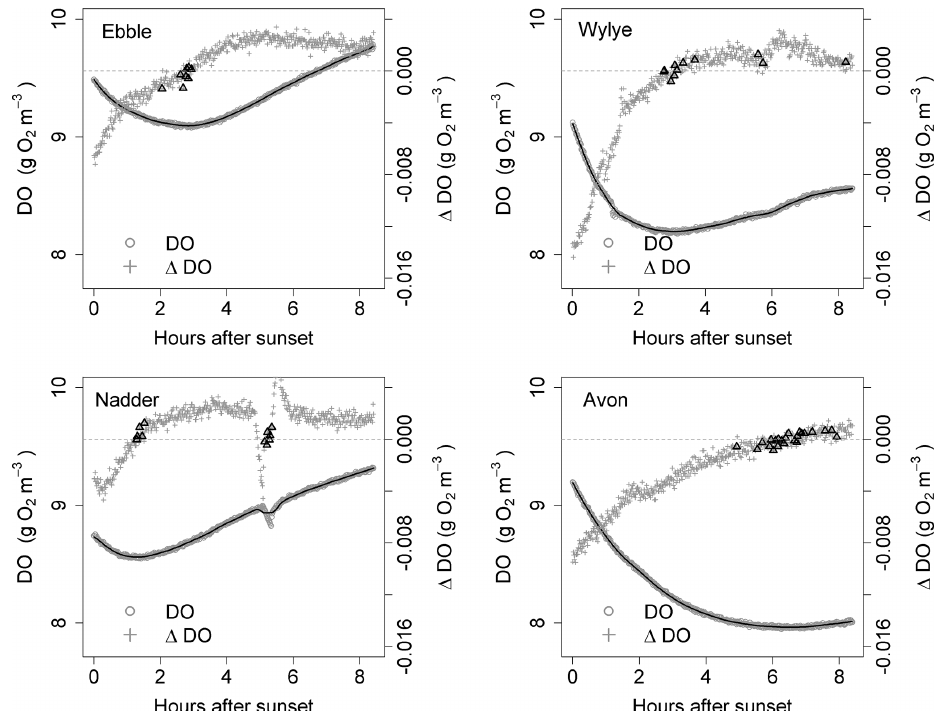
Figure 5. Time series for DO and (cid:49) DO for the night of 16 to 17 May. (cid:49) DO is at 1min intervals. Bold triangles mark those points where there was a change in sign of (cid:49)